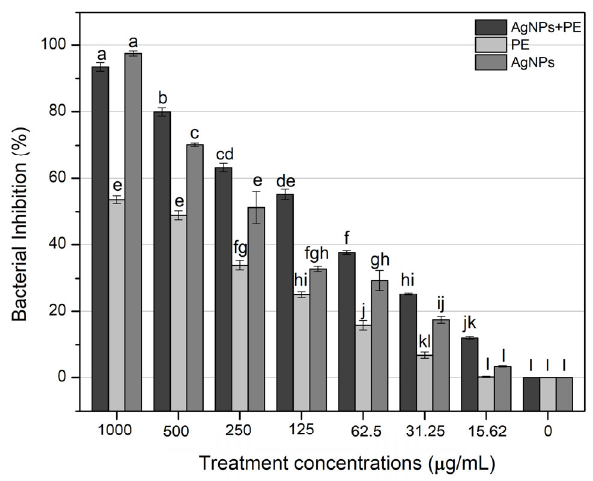
Figure 10. Inhibition of X. axonopodis in response to different concentrations (1000 µ g/mL, 500 µ g/mL, 250 µ g/mL, 125 µ g/mL, 62.5 µ g/mL, 31.25 µ g/mL, 15.62 µ g/mL) of washed silver nanoparticles (AgNPs), plant extract-coated silver nanoparticles (AgNPs-PE) and plant extract (PE). Bars with zero concentration represent control. Bars with the same letters are not significantly different. Different concentrations of each treatment were analyzed by Tukey’s HSD separately.